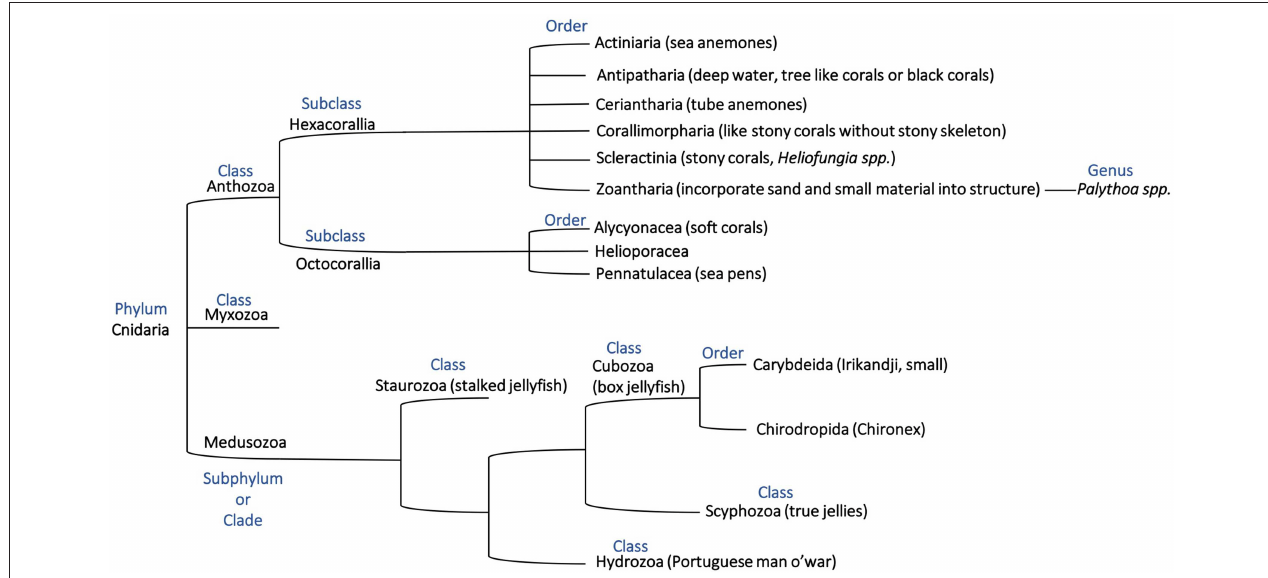
FIGURE 1 | Phylogenetic tree representing the phylum Cnidaria based on previous descriptions (Bridge et al., 1992, 1995; Berntson et al., 1999; Marques and Collins, 2004; Collins et al., 2006; Daly et al., 2007; Jimenez-Guri et al., 2007; Feng et al., 2014; Zapata et al., 2015 ) and showing the relationship of organisms discussed in this